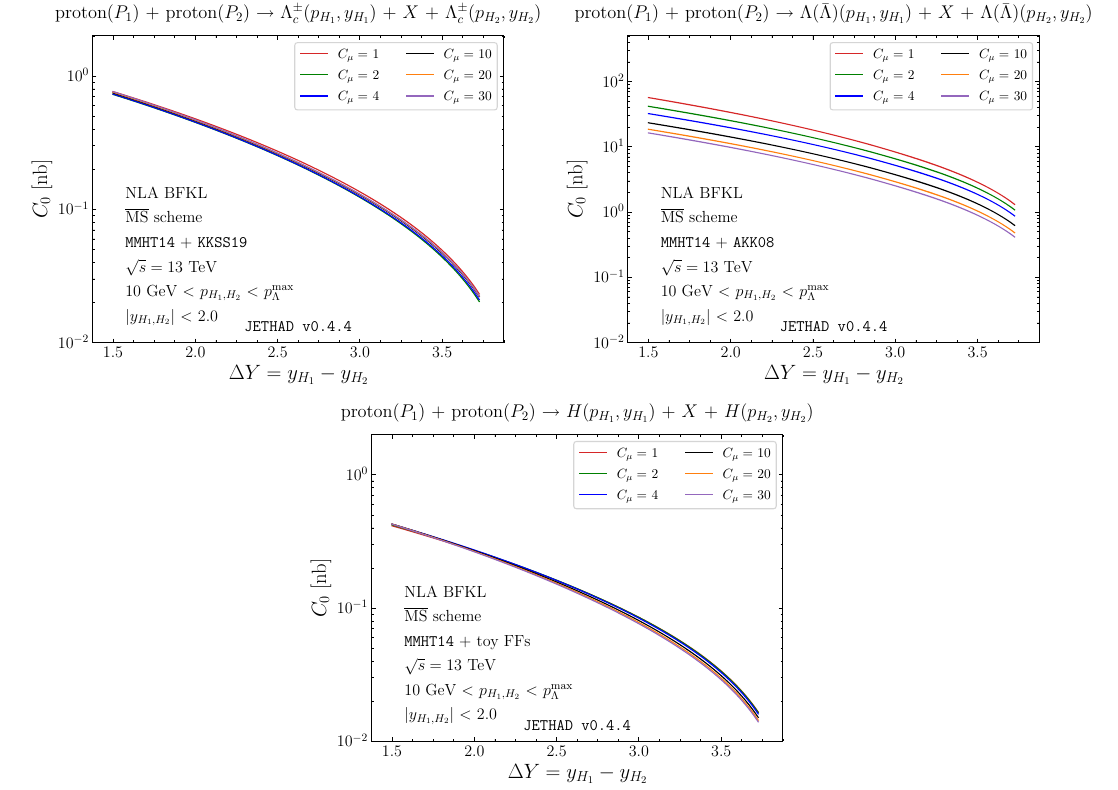
Fig. 9 Behavior of the ϕ -summed cross section, C 0 , as a function of (cid:5) Y , in the dihadron production channel, and for on progressive energy-scale variation in the range 1 < C μ < 30 is done